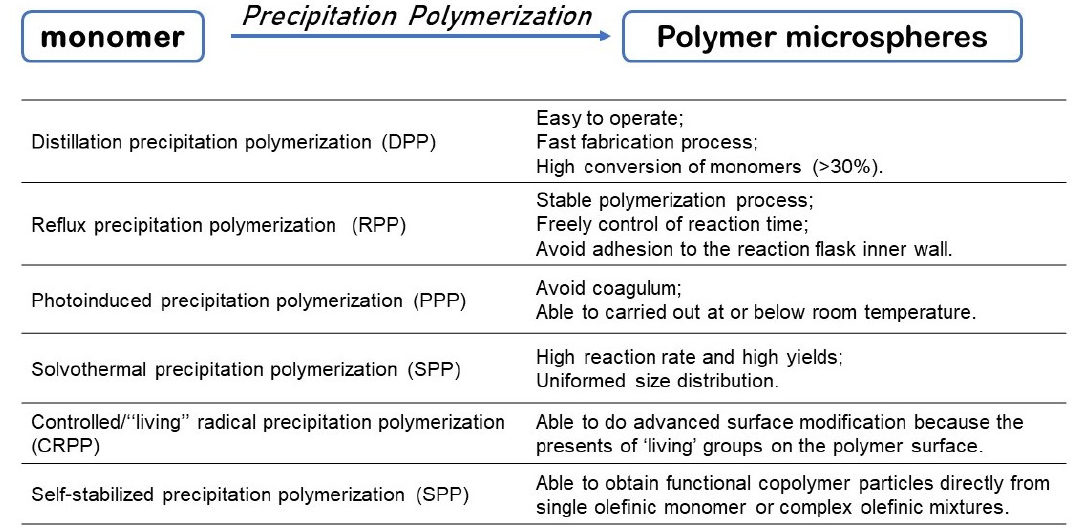
Figure 3. Advantages of different precipitation polymerization techniques in preparation of polymer microspheres [29–39].